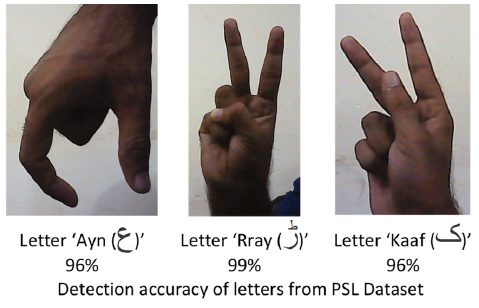
Figure 10. Processing hand gestures (PSL dataset).